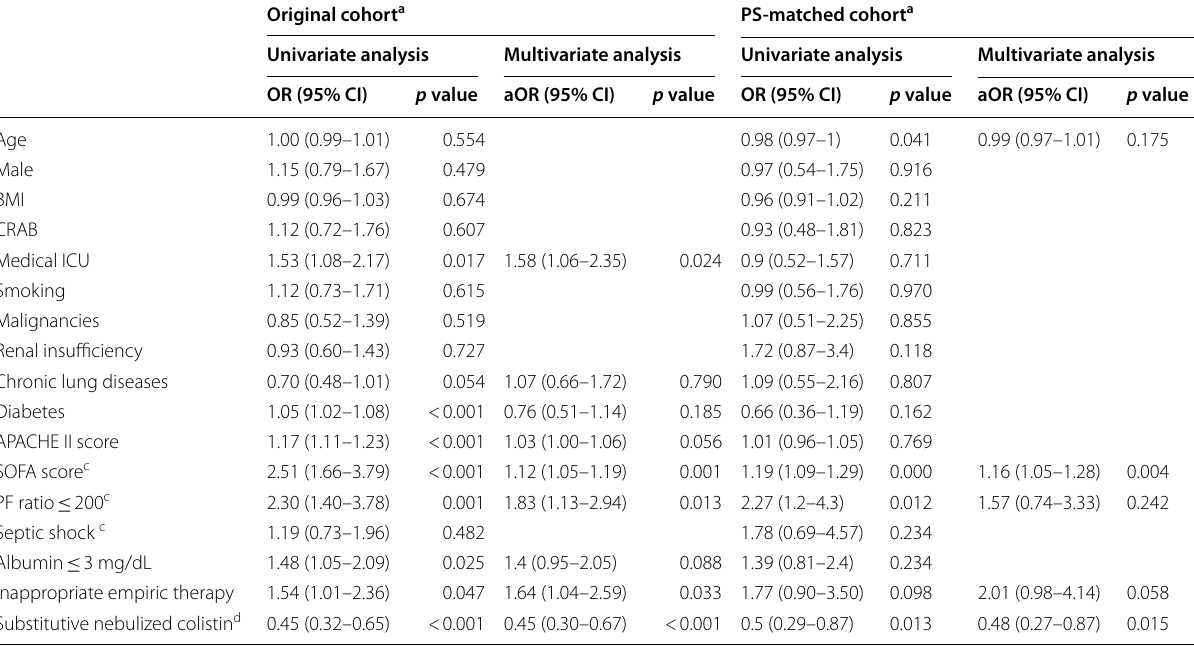
Table 4 Univariate and multivariate analyses of clinical factors associated with day 14 clinical failure in ICU patients with nosocomial pneumonia caused by